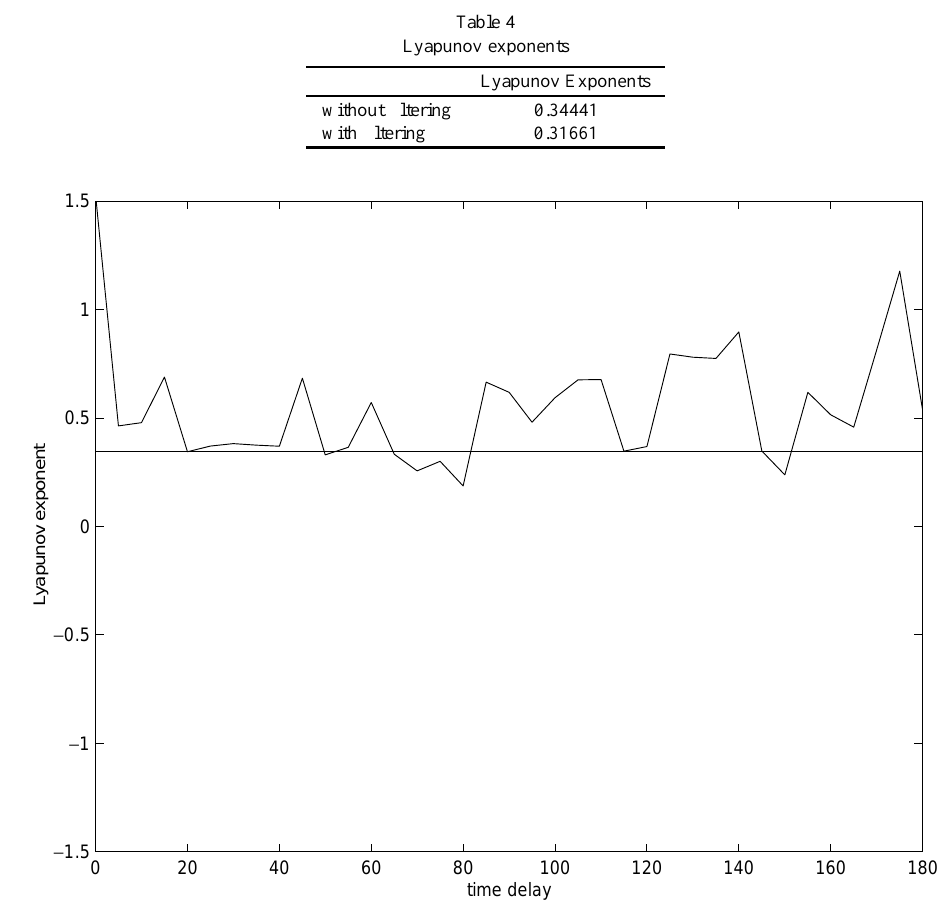
Fig. 12. Evolution of the Lyapunov exponent with respect to time